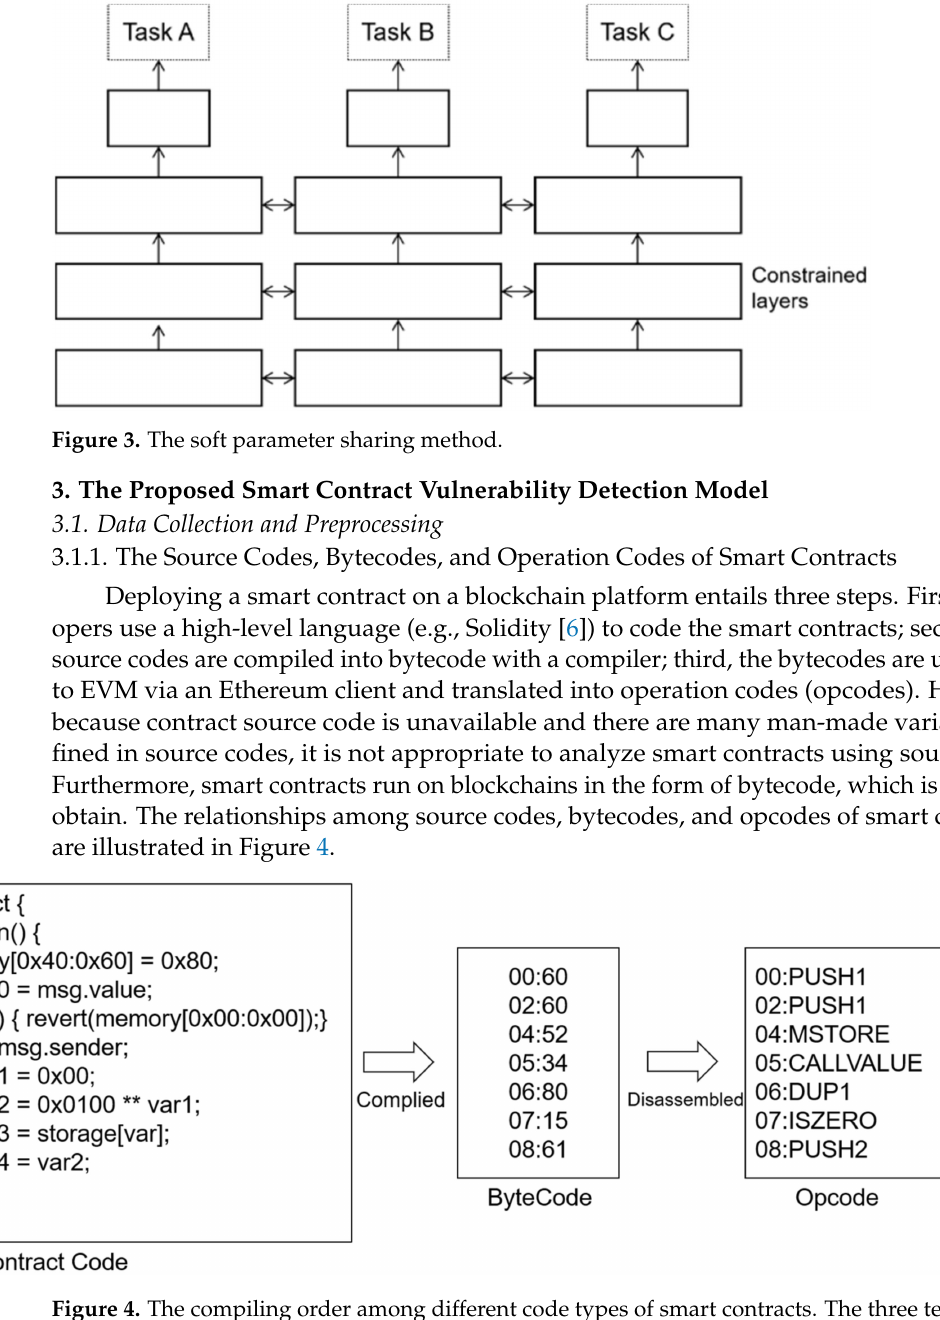
Figure 4. The compiling order among different code types of smart contracts. The three text frames from left to right represent the three code types, respectively. The leftmost frame represents the source codes of smart contracts, which are written in a high-level programming language, Solidity, where ** represents the exponential operator. The middle frame represents the byte codes of smart contracts, which are a cluster of hexadecimal digits corresponding to a specific operation code, for example, the bytecode 60 in the first line corresponds to the opcode PUSH1 in the first line of the rightmost frame, which represents the operation codes. When processing the smart contracts, the source codes are firstly compiled into byte codes, then into operation codes, that is, opcodes, which are used as data in the